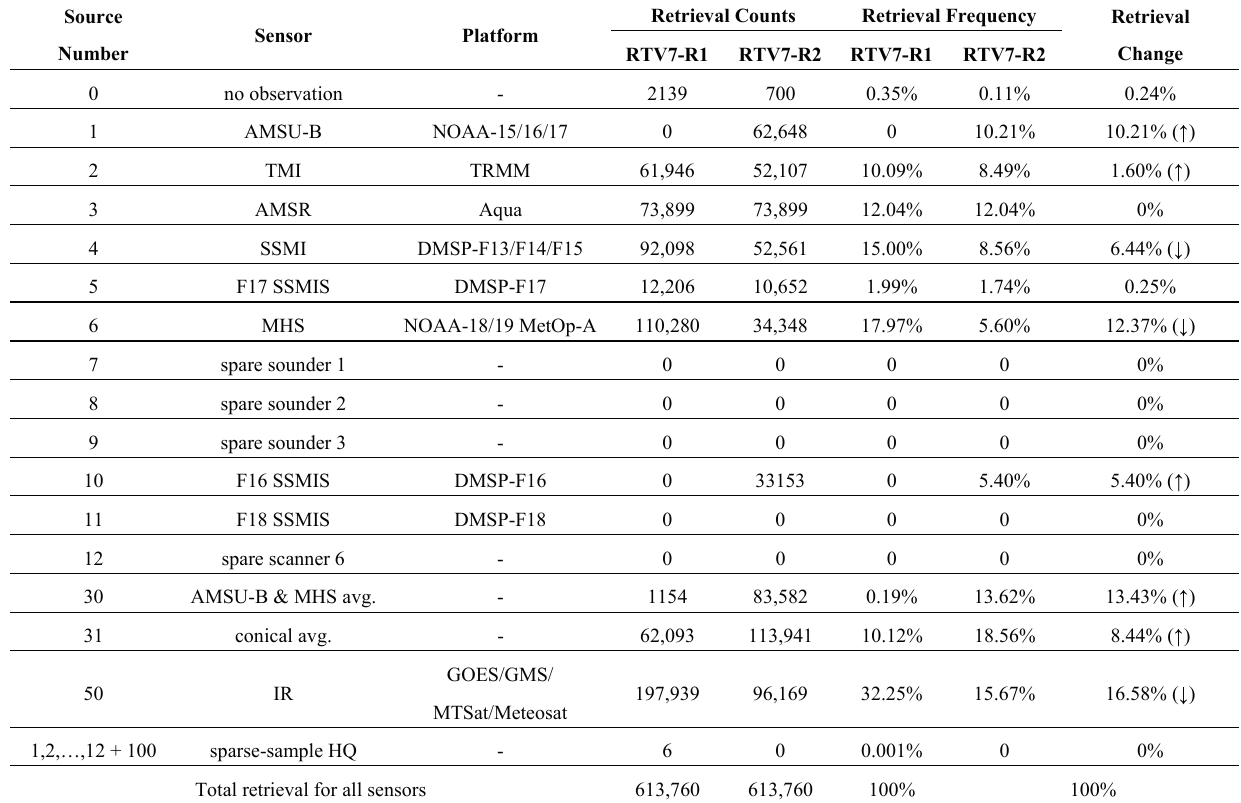
Table 3. Retrieval counts and retrieval frequency of all passive microwave and infrared sensors introduced into the TMPA Processing for all grids over the Jinghe river basin a